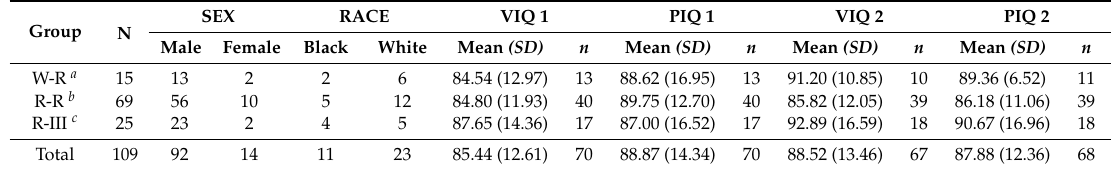
Table 1. Descriptive summary of demographic data, Verbal IQs (VIQ) and Performance IQs (PIQ) available by testing